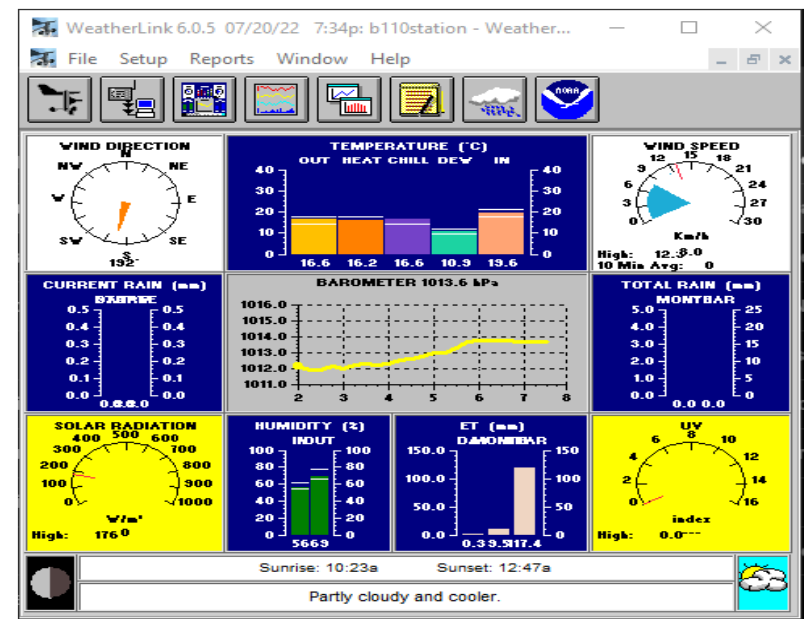
Figure A2. Weather station data obtained using Weather Link software.